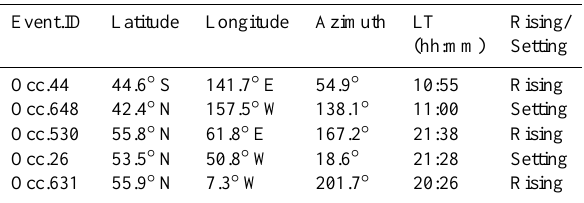
Table 3. Parameters of the RO example events illustrated in Figs. 4 and 5.